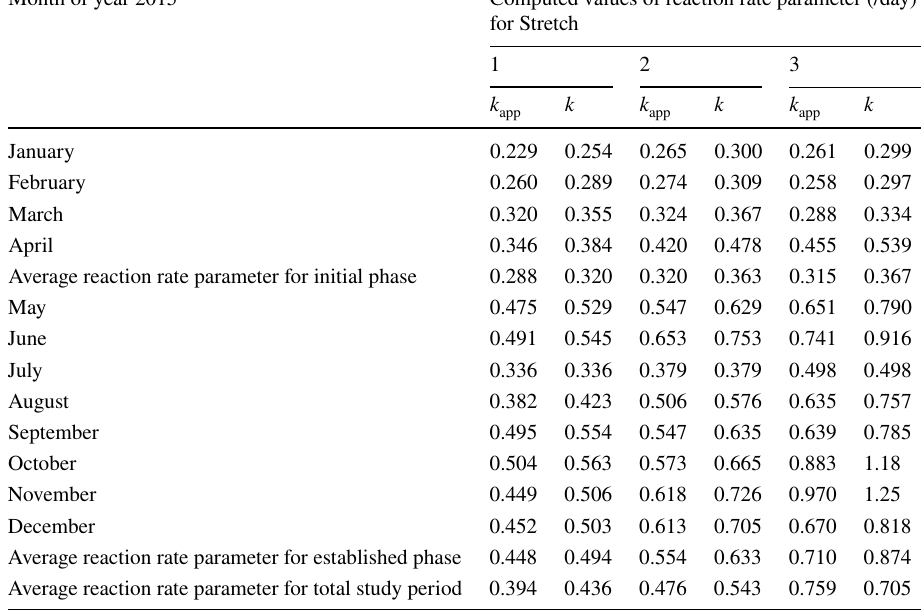
k for the month of January app and